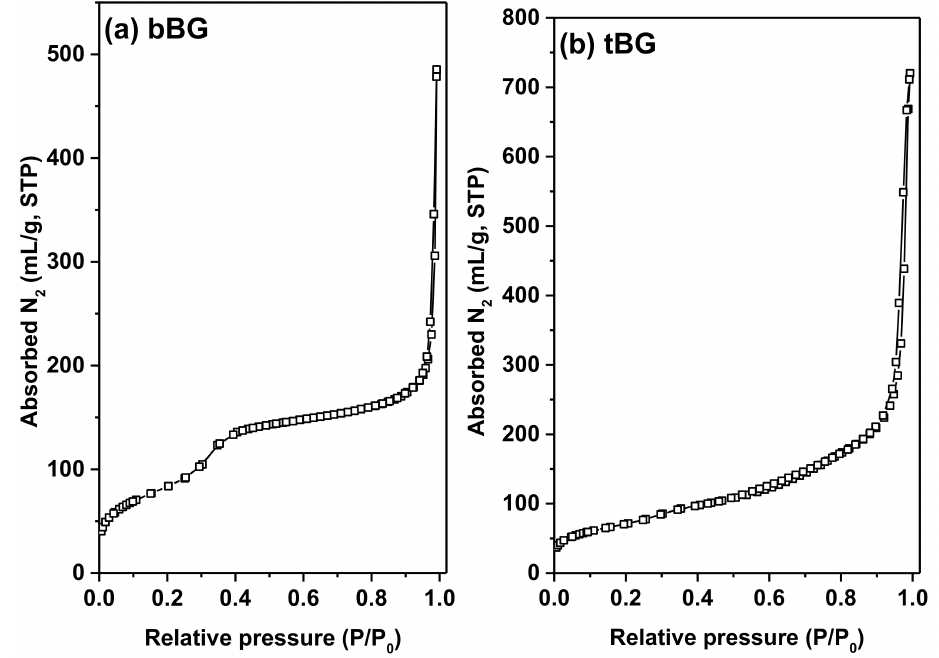
Figure 4. Adsorption-desorption isotherms of ( a ) bBG and ( b ) tBG nanobioglasses.